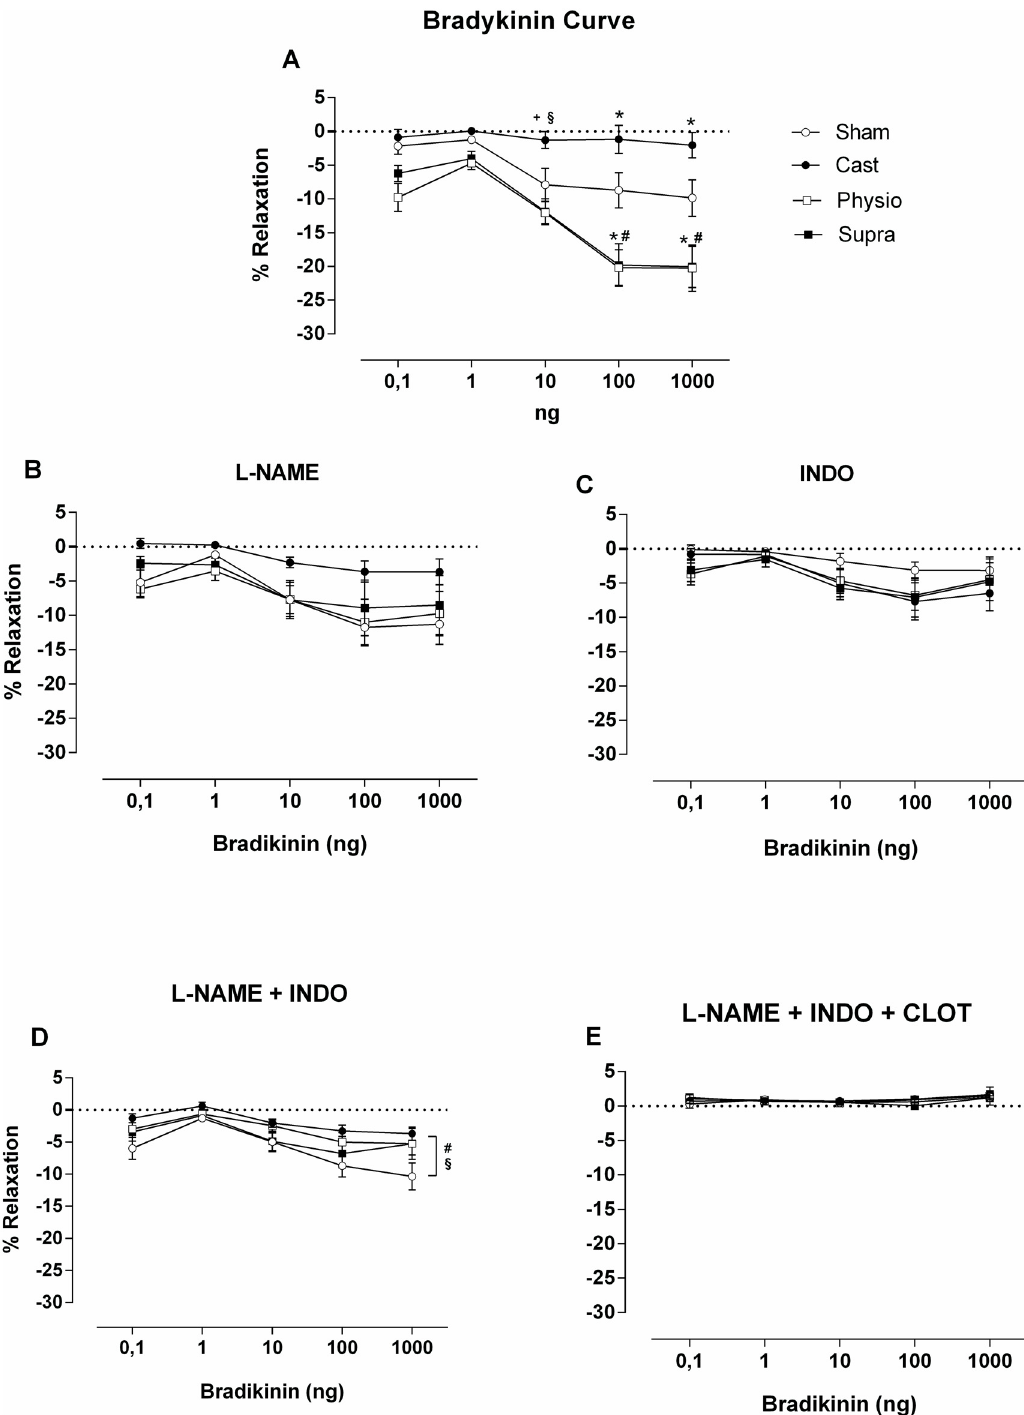
Fig 3. Vasodilator response to increasing concentrations of bradykinin (BK: 0.1 – 1,000 ng). Before (A) and after inhibition with L-NAME (B), indomethacin (INDO) (C); L-NAME + INDO (D), and L-NAME + INDO + clotrimazole (E). The values are expressed as the mean ± SEM. * p < 0.05 compared with the SHAM group, #p < 0.05 compared with the CAST group, +p < 0.05 compared with the PHYSIO group, and §p < 0.05 compared with the SUPRA group.